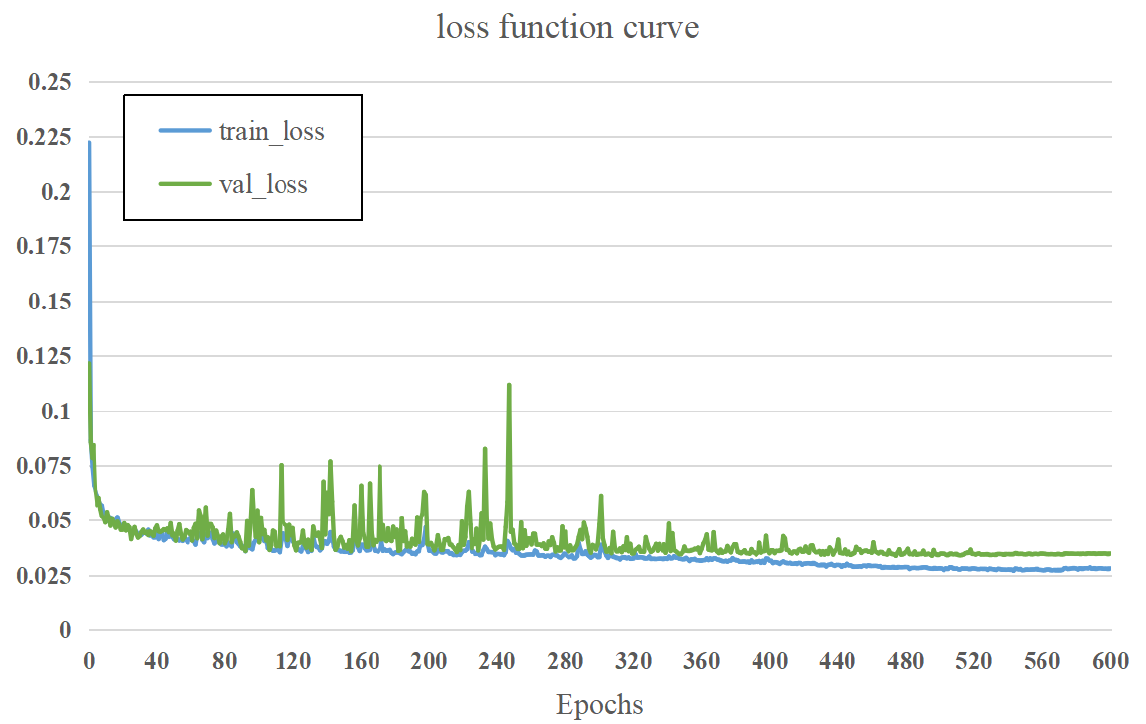
Figure 8. Loss function curve of RIIAnet.